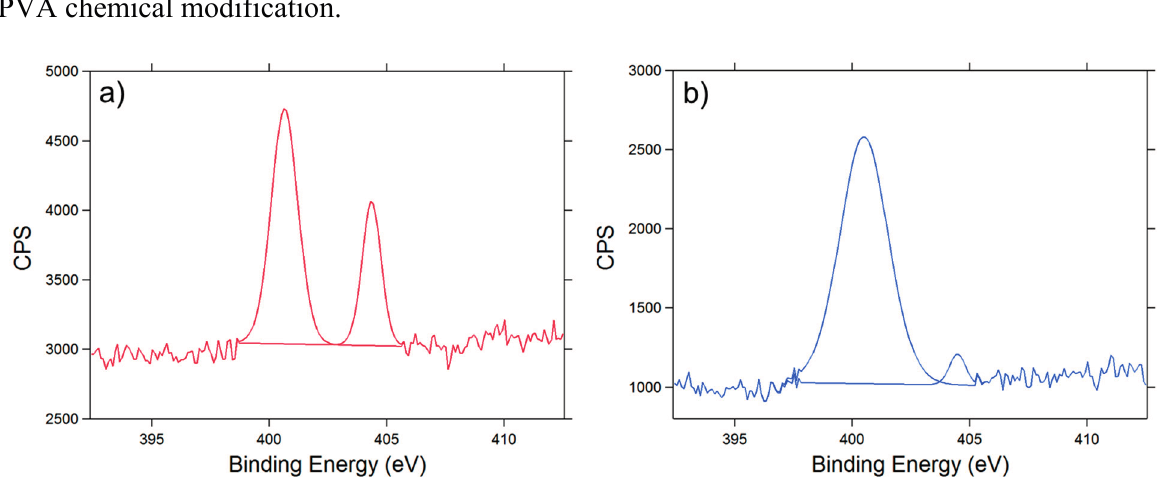
Figure 4. High-resolution XPS N 1s core level spectra of ( a ) PVA-N 3 and ( b ) PVA-NH 2 .